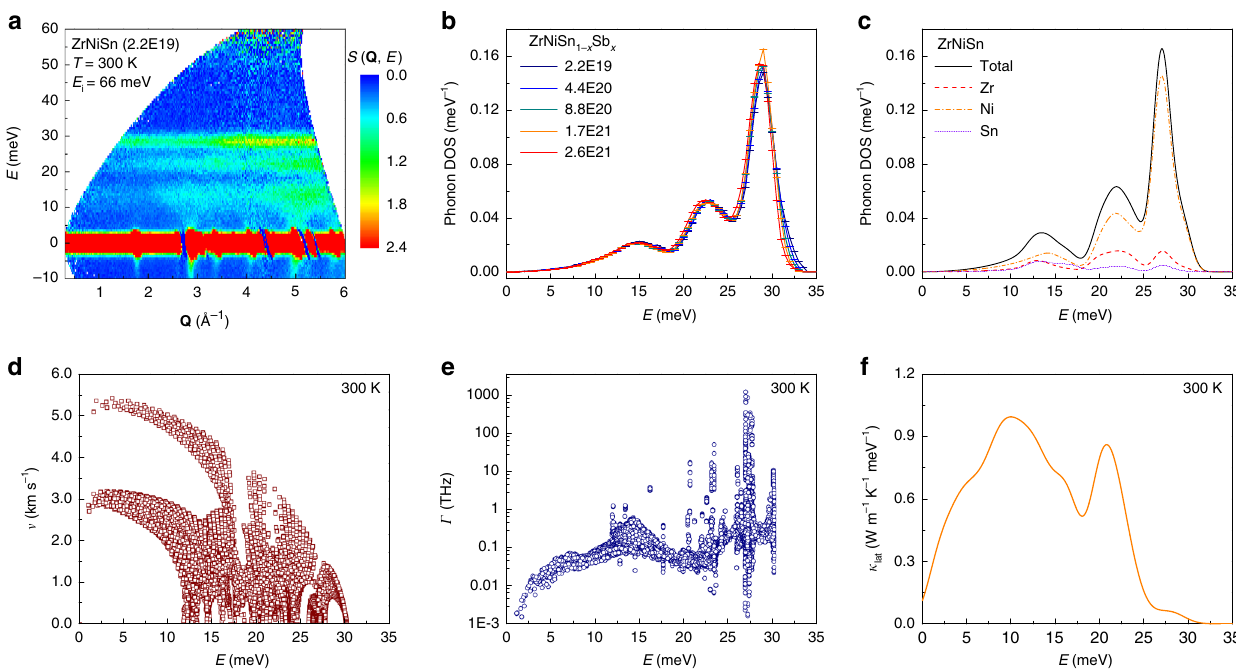
Fig. 3 Phonon DOSs and calculated lattice thermal conductivity. a Experimental dynamical structure factor, S ( Q , E ), measured with inelastic neutron scattering for the ZrNiSn sample with E i = 66 meV. b Neutron-weighted phonon DOS of the ZrNiSn 1- x Sb x compounds with different carrier concentration n (cm − 3 ). c Total and partial neutron-weighted phonon DOS for ZrNiSn obtained from fi rst-principles calculations. d Calculated group velocities, ν , and e scattering rate, Γ , for ZrNiSn. f calculated energy-dependent lattice thermal conductivity for ZrNiSn at 300